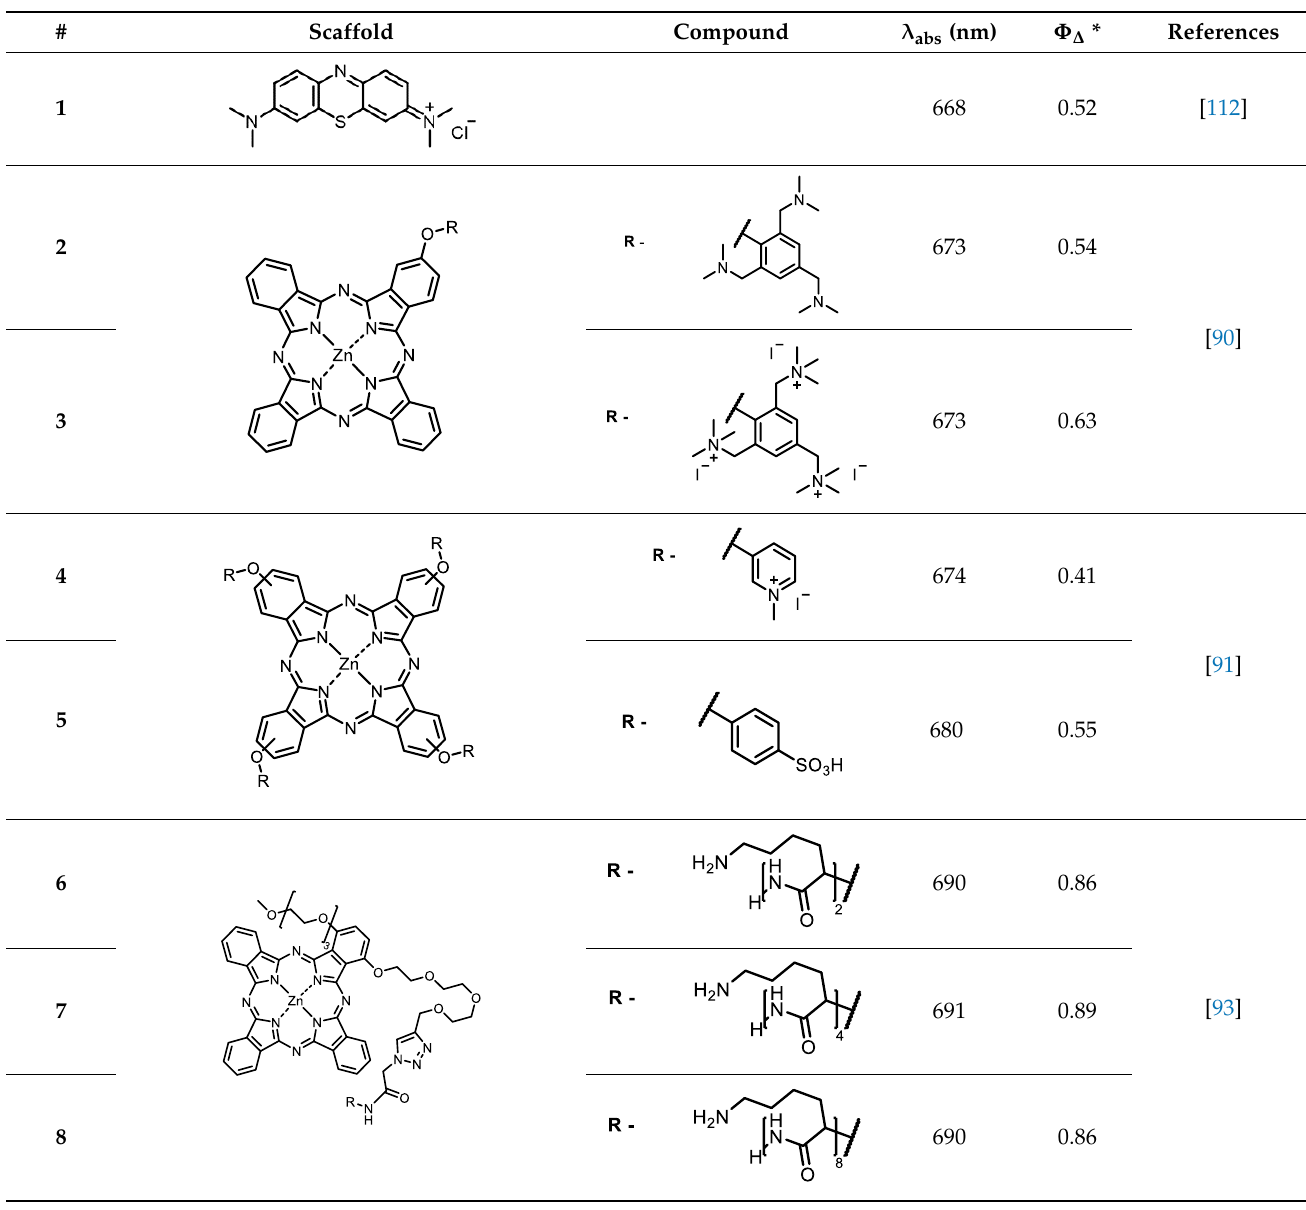
Table 2. Singlet oxygen generators.